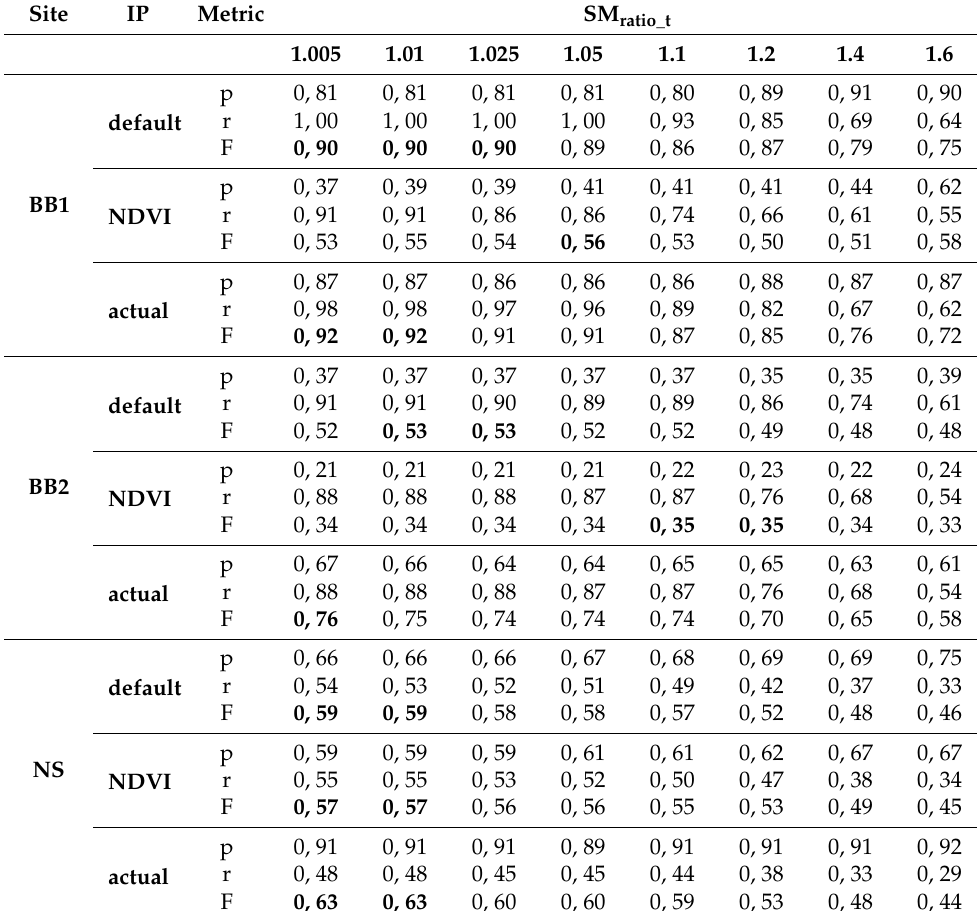
Table 1. Summary of detection accuracy (precision, recall and F-score) depending on the SM ratio_t value employed for discriminating soil moisture increases as irrigation and the irrigation period (IP) considered. The highest F-score for each IP is shown in